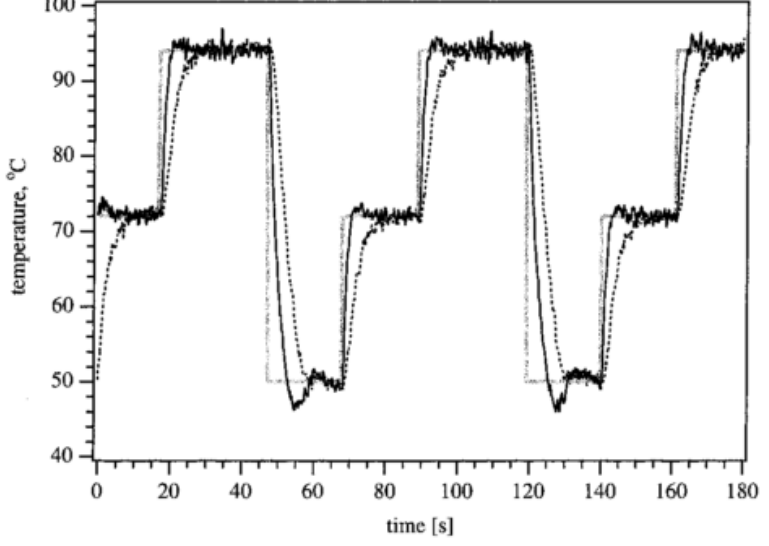
Figure 2. Temperature versus time for Polymerase Chain Reaction (PCR) amplification. The gray solid line represents the set-point temperature, the black solid line is the temperature of the bottom Peltier element and the dashed line is the reaction mix temperature. Reprinted with permission from [4]. Copyright 2000 American Chemical